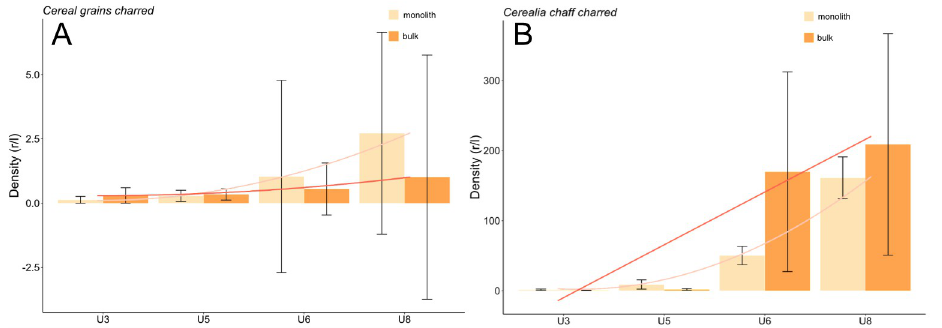
Fig 10. A, B Density of charred cereal grains and chaff (mean ± standard error).